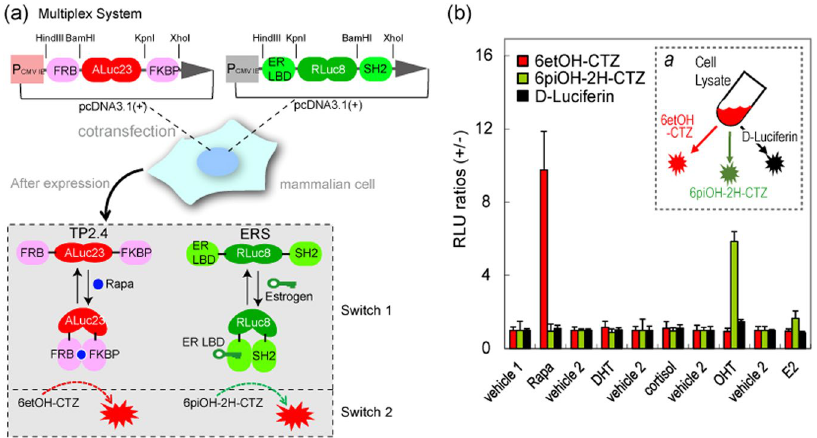
Figure 3. ( a ) Schematic diagram of a multiplex assay system with two pcDNA3.1( + ) vectors encoding molecular tension probe 2.4 (TP2.4) and ER LBD-RLuc8-SH2 (ERS), respectively. After expression, TP2.4 and ERS coexist in mammalian cells, which are ready to illuminate ligand activity. The working mechanisms of TP2.4 and ERS are briefly illustrated in the box-highlighted Switches 1 and 2. Upon stimulation by a ligand, TP2.4 or ERS exerts an intramolecular protein-to-protein interaction (PPI) (Switch 1). This PPI enhances the sandwiched luciferase’s activity. The enhanced activities are pinpoint visualized with specific coelenterazine (CTZ) analogues (Switch 2). ( b ) Specific optical intensities of the substrates in the multiplex assay system carrying two luciferase-based probes. Conventional assays are unable to discriminate the two optical signals. However, the present multiplex system pinpoint-illuminated the rapamycin or estrogen antagonist (OHT) activities without any signal contamination. Vehicles 1 and 2 are negative controls with 0.1% alcohol and 0.1% DMSO, respectively. Inset a briefly illustrates the experimental procedure with the specific substrates. The live cells were firstly stimulated with rapamycin and estrogen, lysed, and pinpoint-illuminated with a specific luciferin. Abbreviations: FRB, the rapamycin-binding domain of mTOR; FKBP, FK506-binding protein; ER LBD, the ligand binding domain of human estrogen receptor; SH2, the SH2 domain of v -Src; Rapa, rapamycin; DHT, 5 α -dihydrotestosterone; OHT, 4-hydroxytamoxifen; E2, 17 β